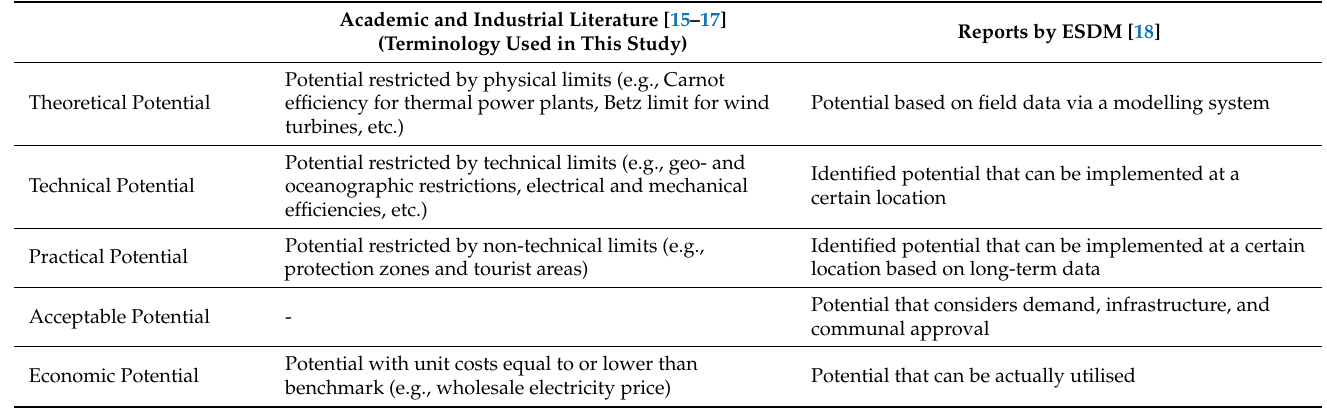
Table 1. Different definitions of potentials found in literature.